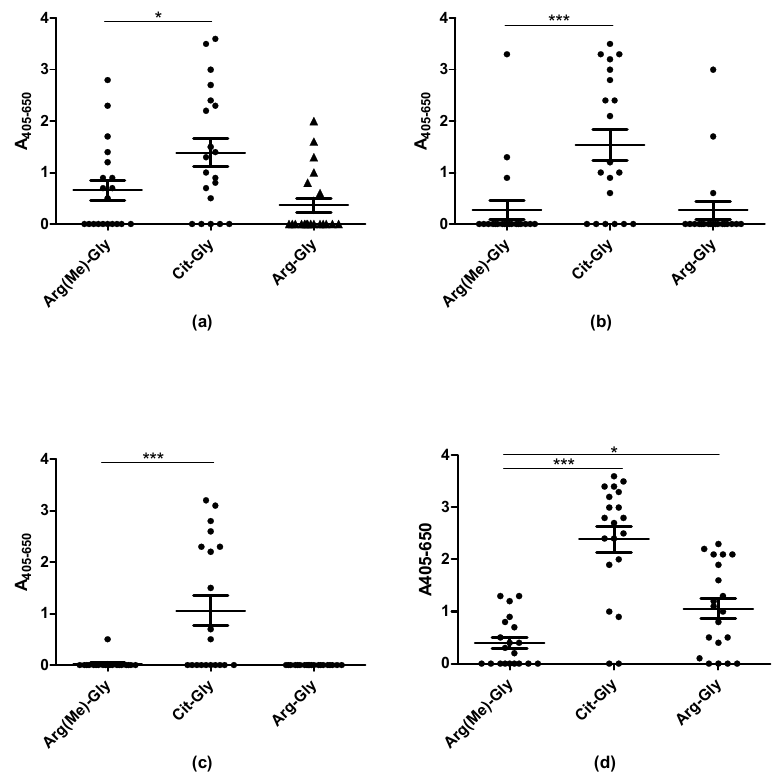
Figure 4. Reactivity of rheumatoid arthritis sera (n = 20) to citrullinated and Arg(Me)-substituted peptides analyzed by streptavidin capture ELISA. ( a ) Antibody reactivity to substituted peptides, using the EBNA1 peptide ARGGSRERARGRGRG–R–GEKR as template; ( b ) Antibody reactivity to substituted peptides, using the EBNA1 peptide GGSKTSLYNLR–R–GTALAIPQ as template; ( c ) Antibody reactivity to substituted peptides, using the proteoglycan peptide PQASVPLRLT–R–GSRAPISRAQ as template; ( d ) Antibody reactivity to substituted peptides using the EBNA2 peptide GQGRGRWRG–R–GRSKGRGRMH as